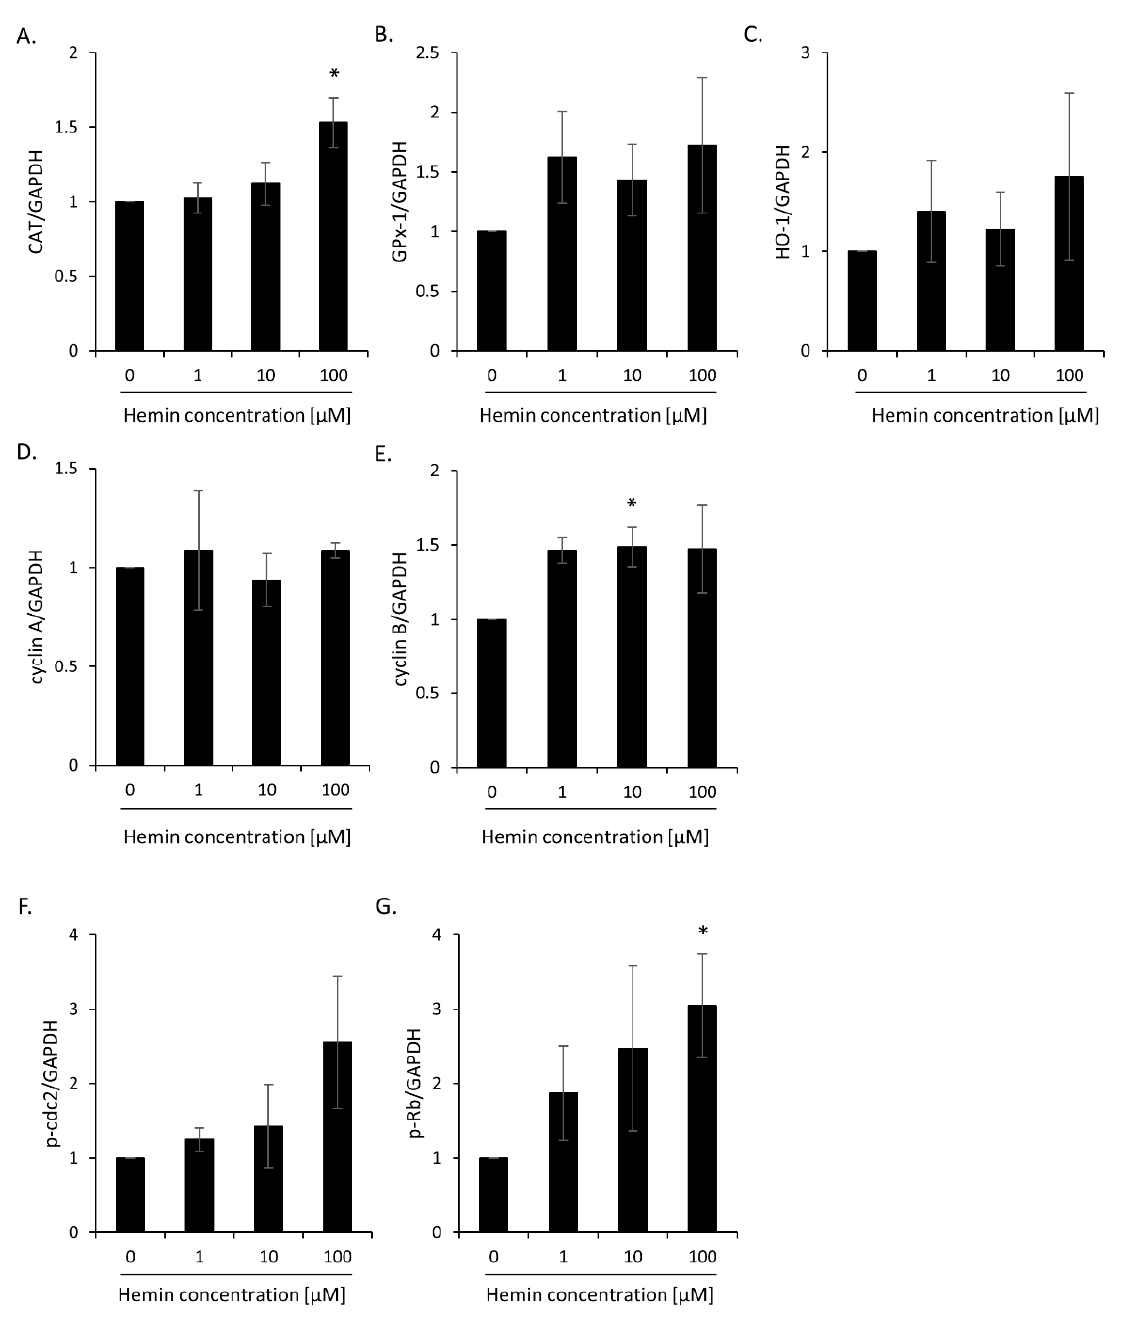
Figure A1. Evaluation of protein expression in HCT116 cells treated with 2.5 µ M IRINO subjected to 1, 10, or 100 µ M hemin: antioxidative and proliferation markers. Quantification is based on the densitometry analysis performed with the use of ImageJ software. Data are shown as the ratio of the protein amount to respective protein loading control (GAPDH): ( A ) CAT; ( B ) GPx-1; ( C ) HO-1; ( D ) cyclin A; ( E ) cyclin B; ( F ) p-cdc2; ( G ) p-Rb. Each bar represents mean ± SEM, n ≥ 3; * p < 0.05— hemin concentration vs. 0.